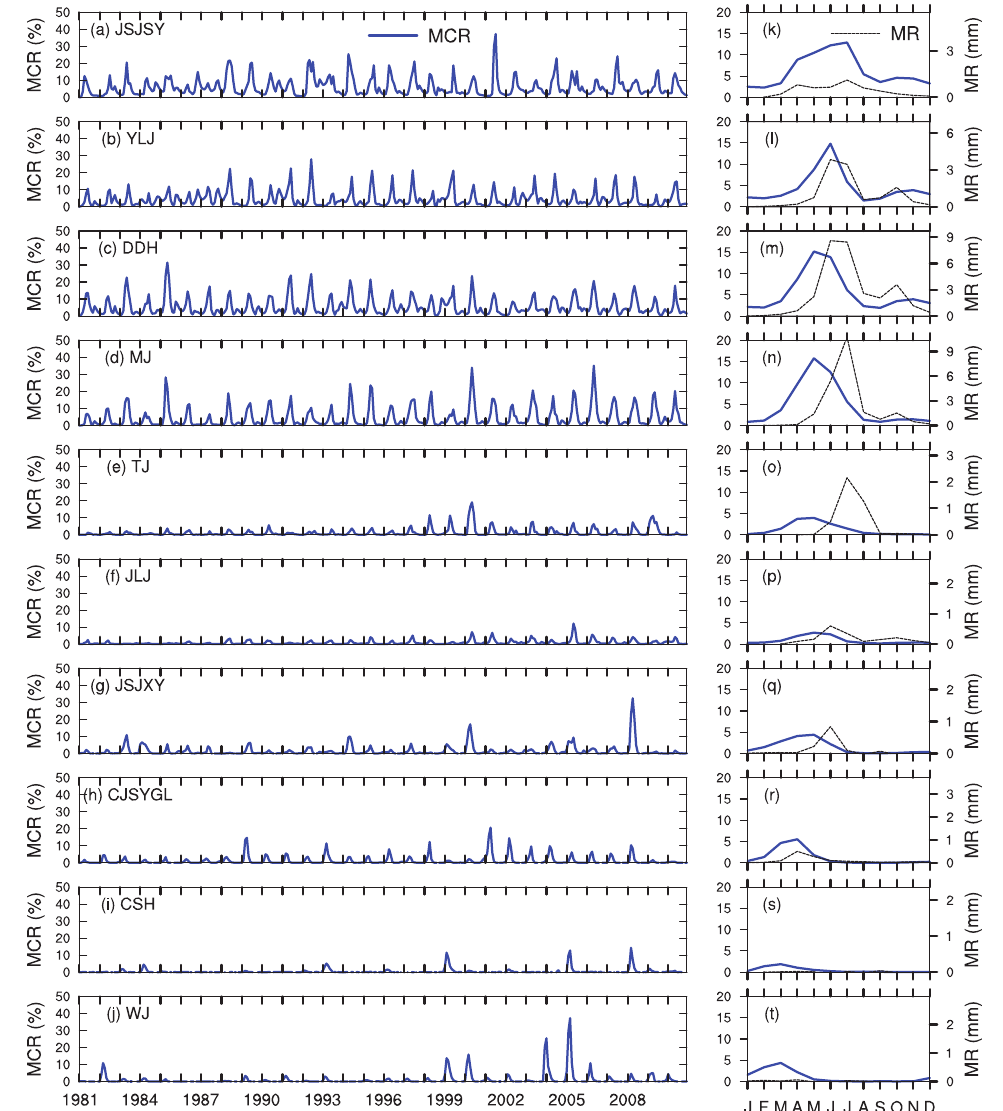
Figure 5. Modeled monthly melt runoff contribution to total runoff (MCR, %) in ten sub-regions ( a – j , blue line) from 1981 and 2010. The corresponding monthly climatology MCR values averaged over the same period ( k – t , blue line) are also shown, and the corresponding monthly climatology melt runoff (MR, mm/month) is illustrated for comparison ( k – t , black